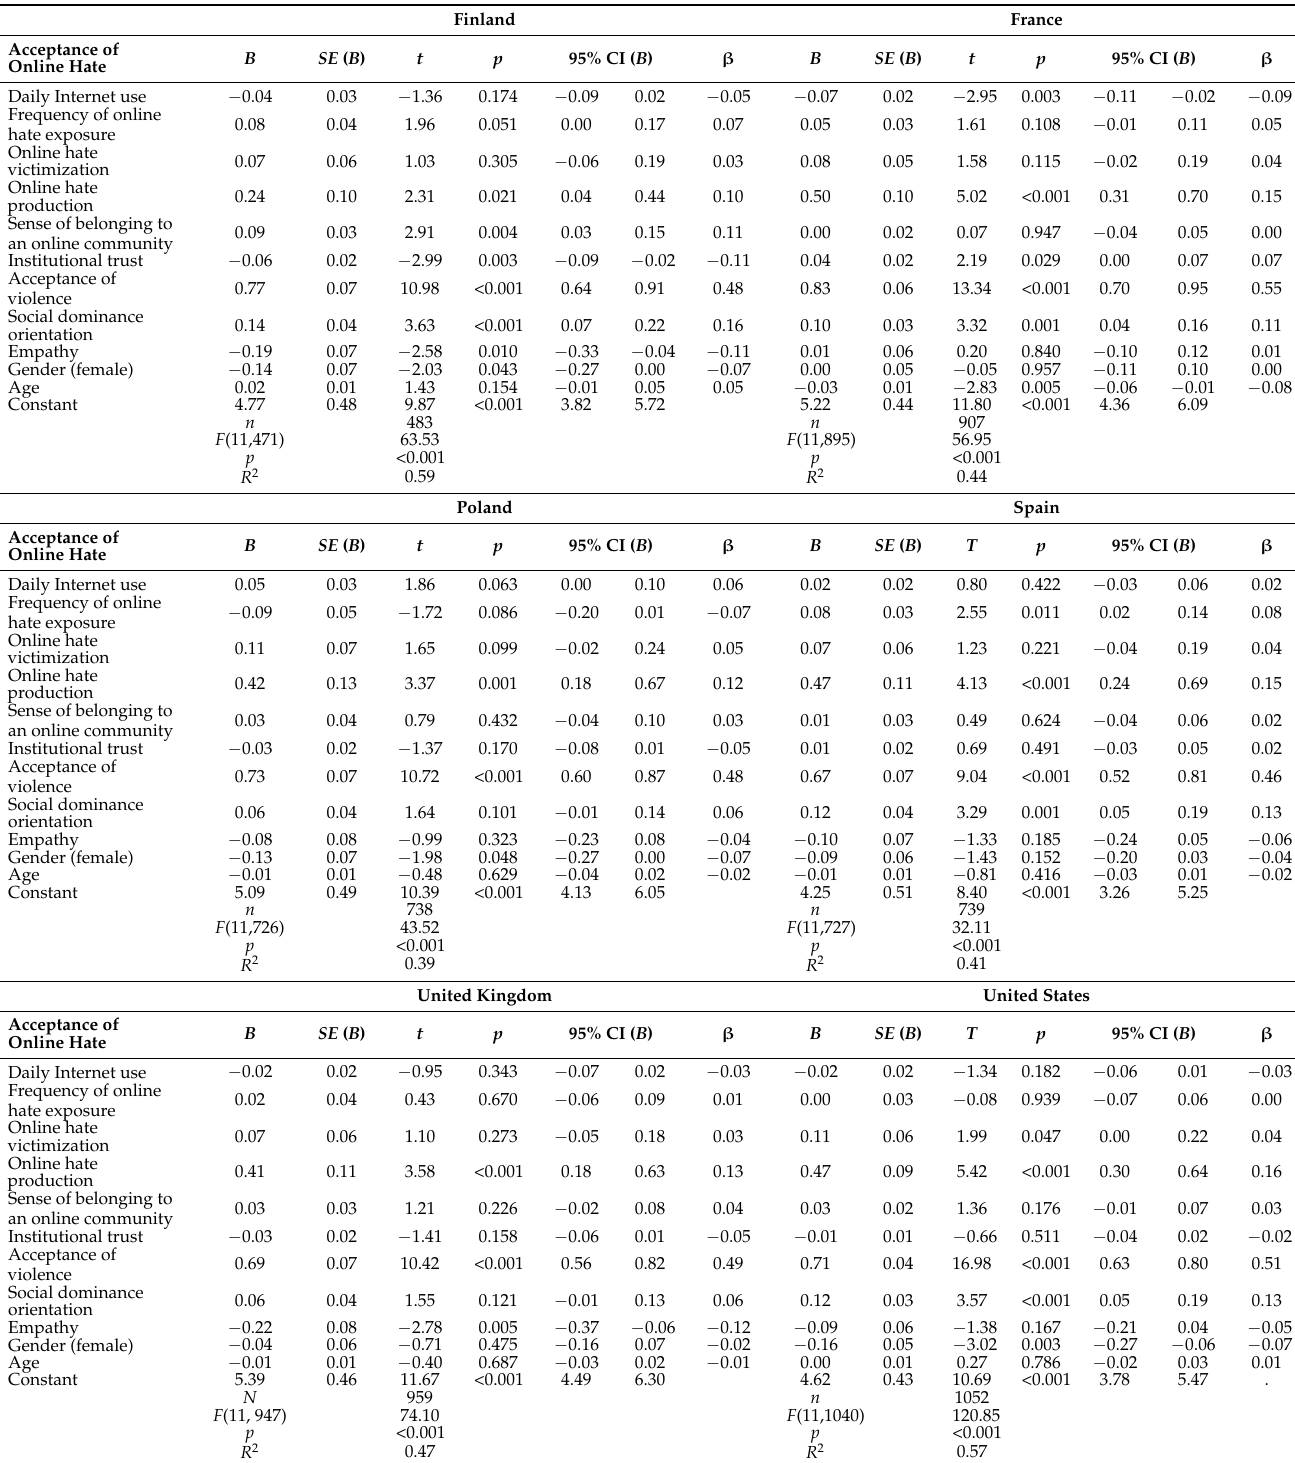
Table 2. Linear regression models for acceptance of online